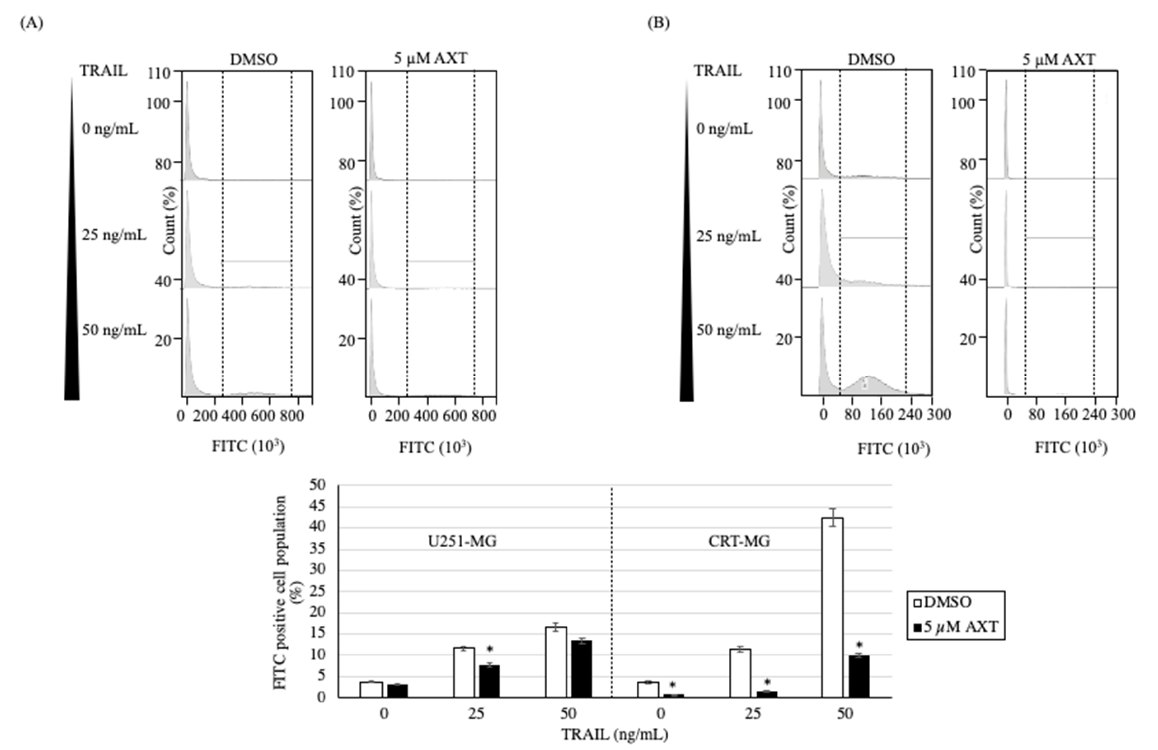
Figure 5. ROS is downregulated by AXT treatment and upregulated by TRAIL treatment, while to a lesser extent in U251-MG compared to CRT-MG. (A) U251-MG cells and (B) CRT-MG cells were treated with 5 µM AXT or 0.1% DMSO in a 6-well plate as control for 3 h prior to TRAIL treatment of 25 or 50 ng/mL for 16 h. Intracellular ROS was measured by staining cells with DCFD-DA and measuring green fluorescence by flow cytometry. Experiments were performed in three independent replicas, and 20,000 cells for each treatment were measured, and a representative figure is shown. Green fluorescence intensity area was defined using H 2 O 2 as positive control (data not shown), and ROS-positive population percentage as means with SDs were presented as graphs below each cell line representative figure. Significance was assessed by Student’s t-test. * p < 0.05.